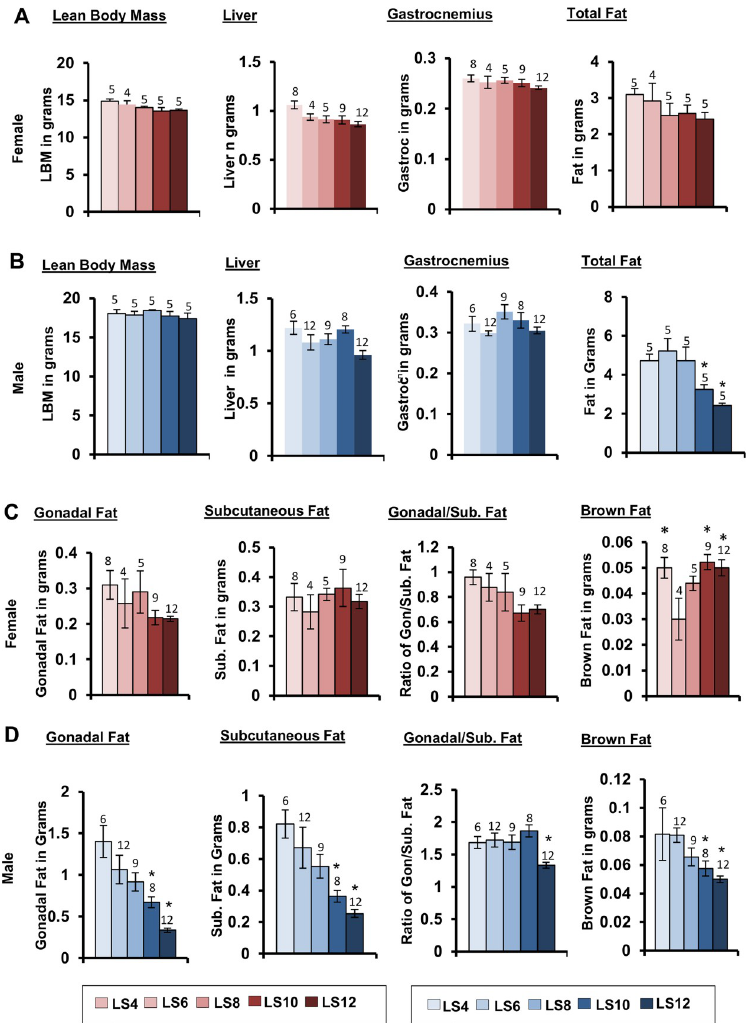
Fig 2. Effect of litter expansion on body composition and fat depots in 15-month-old mice. The lean body mass (LBM), total fat, mass of liver, and gastrocnemius in (A) female and (B) male mice and mass of different fat depots: gonadal, subcutaneous and brown fat in (C) female and (D) male mice. Body composition data represented are the mean ± SEM from 4–5 mice per group. The fat depots data represented are the mean ± SEM from 4–12 mice per group. All groups were compared to control LS6 and were statistically analyzed by one-way ANOVA with Tukey’s and FDR with Benjamini & Hochberg multiple correction test ( � p < 0.05).